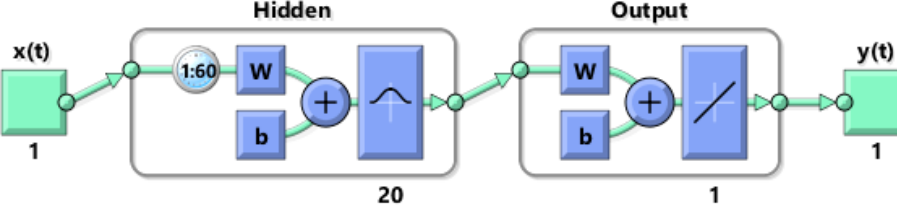
Figure 2. Time-Delay Neural Network flowchart